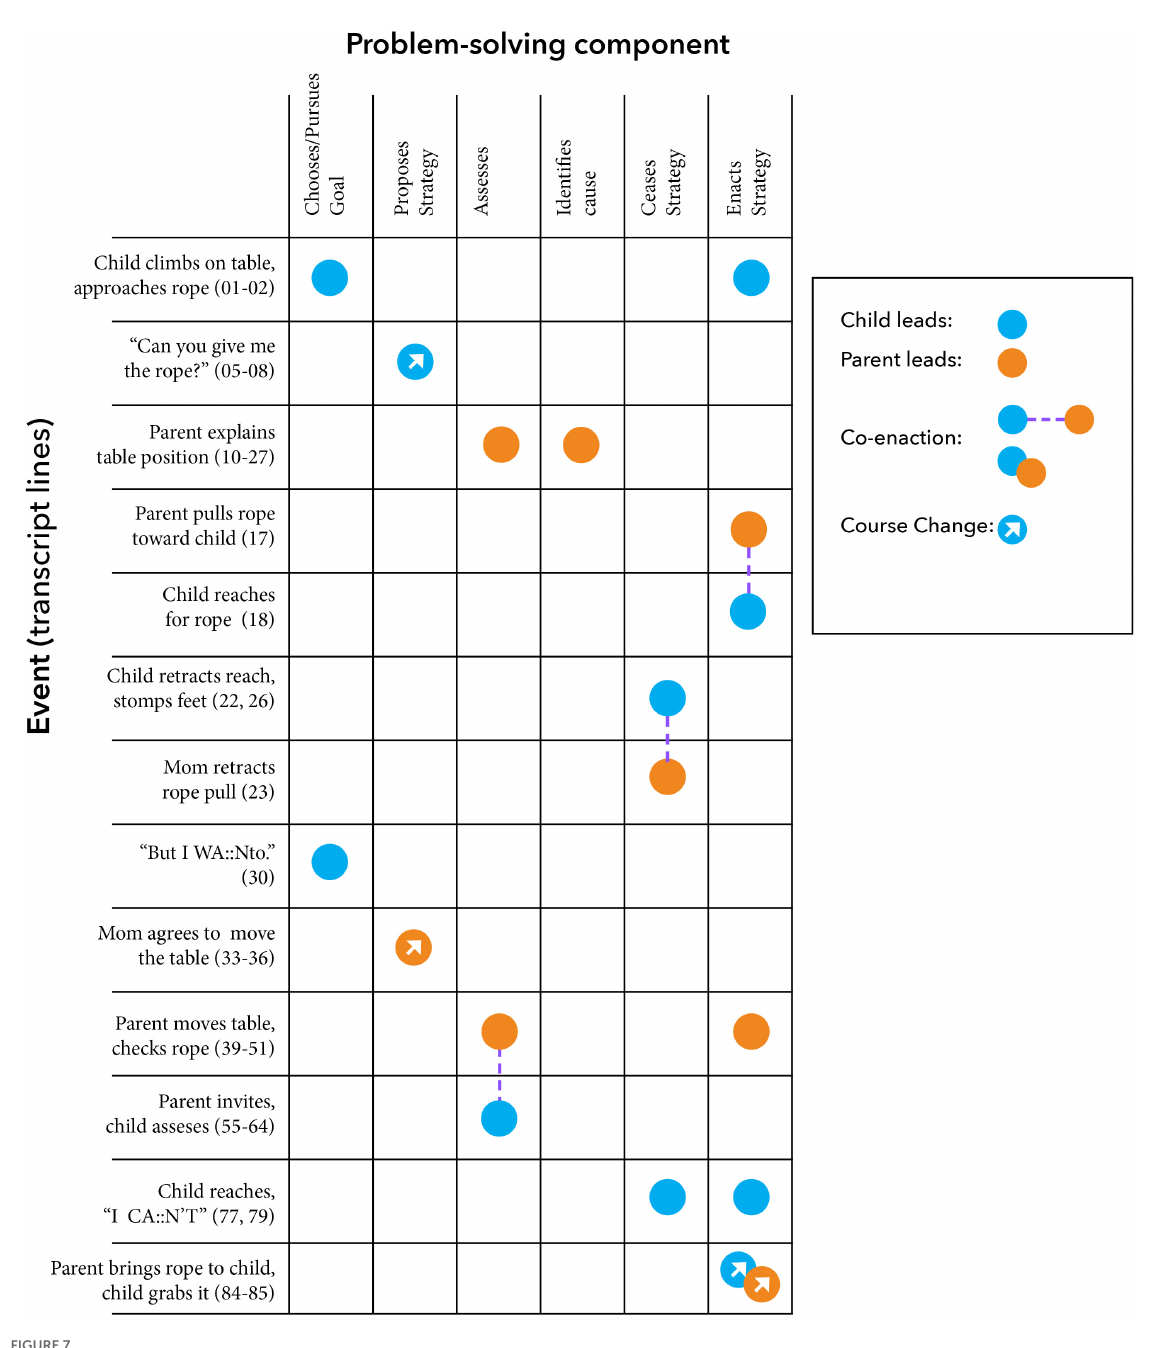
FIGURE7 Matrix for visualizing our decomposed analysis of the “Rope” clip.